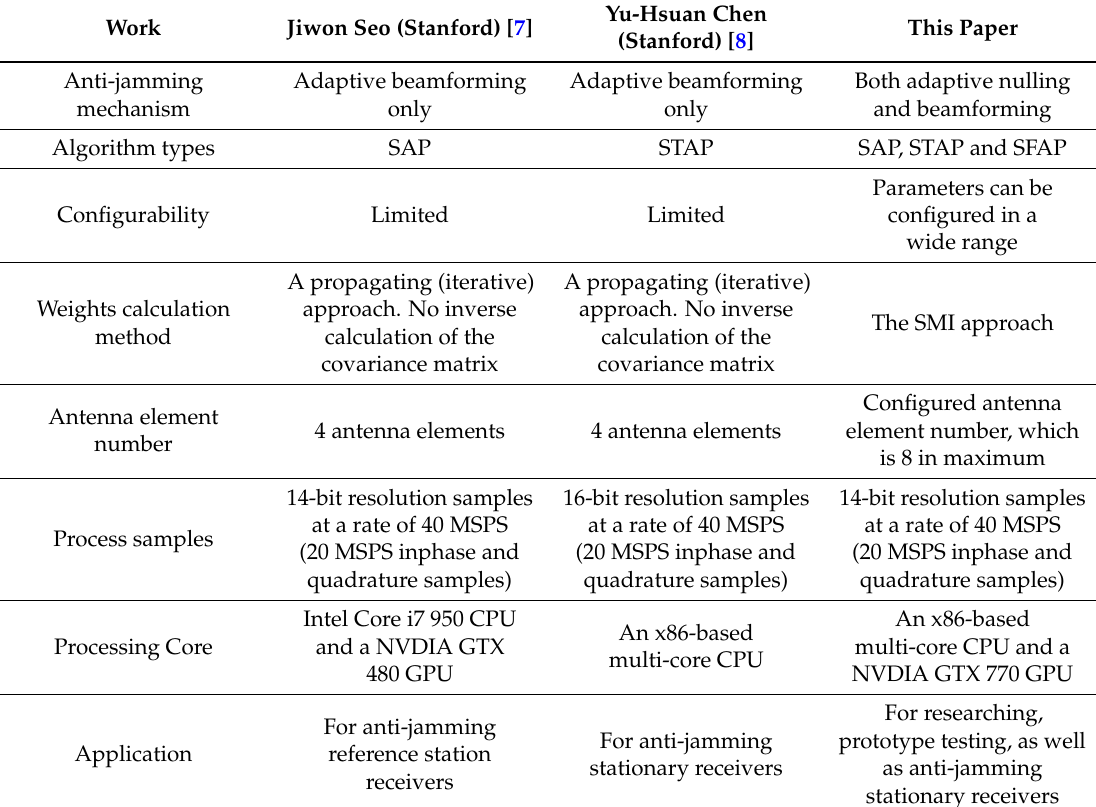
Table 1. Overview of previous work and testbed presented in this